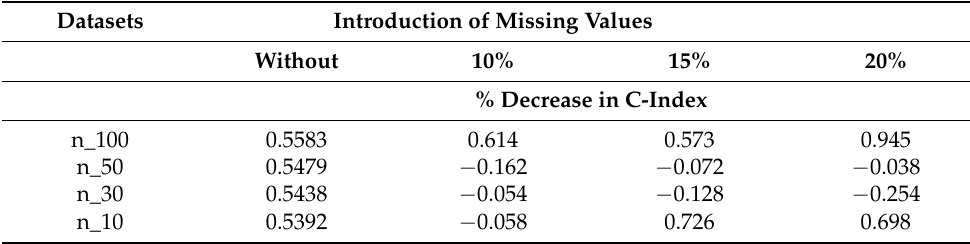
Table 6. FRSF Performance for Different Percentages of Missing Values.